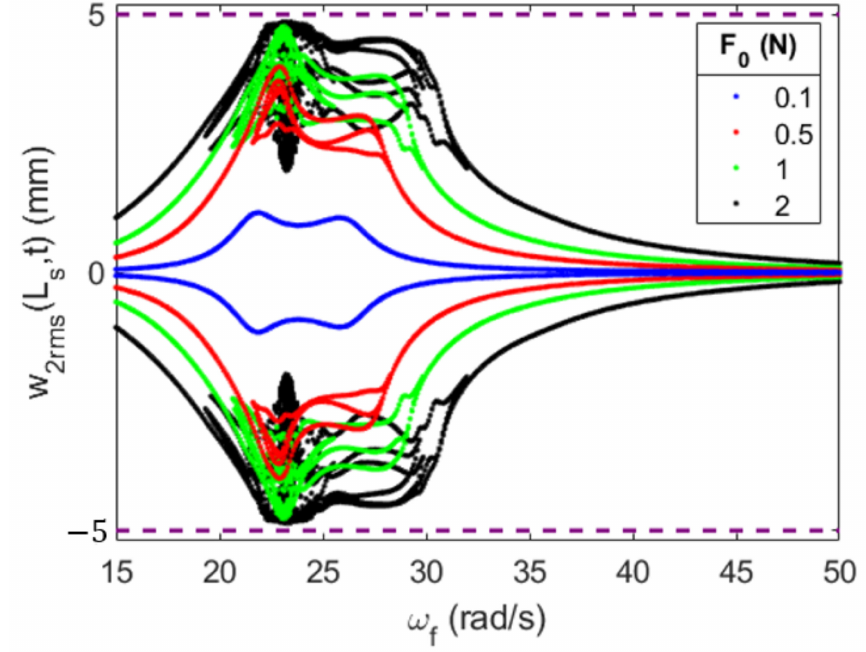
Figure 35. Bifurcation diagram of the absorber’s position with a gap of 5 mm, tip mass of 0.06 kg and substrate thickness of 0.1397